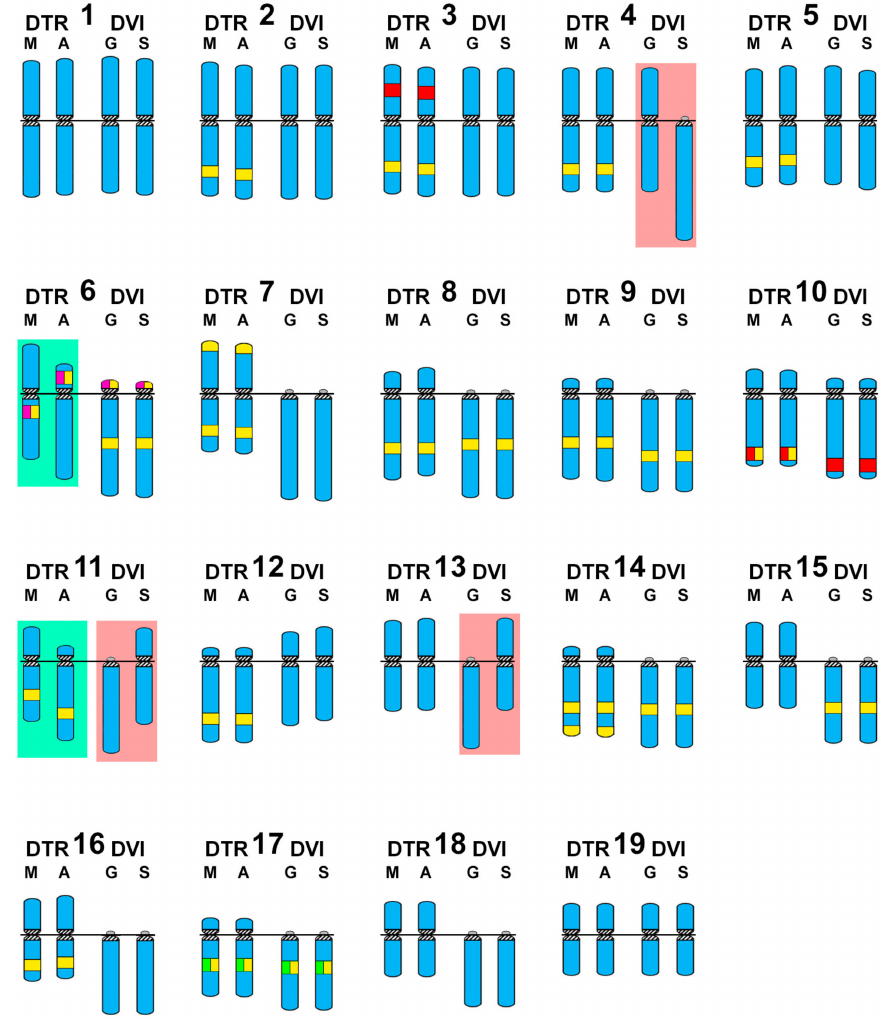
Figure 4. Schematic representation of the wedge shell haploid chromosome complements. For comparative purposes, the schemas of chromosomes 1 to 19 in Donax trunculus (DTR) Mediterranean (M) and Atlantic (A) populations and Donax vittatus (DVI) Galician (G) and Samil (S) populations are represented in quartets. DAPI − /CMA+ bands (yellow), 5S rDNA (red), 45S rDNA (magenta) and H3 histone gene (green) are also represented. The chromosomes showing the most remarkable intraspecific differences are shadowed in light green for Donax trunculus and light pink for Donax vittatus